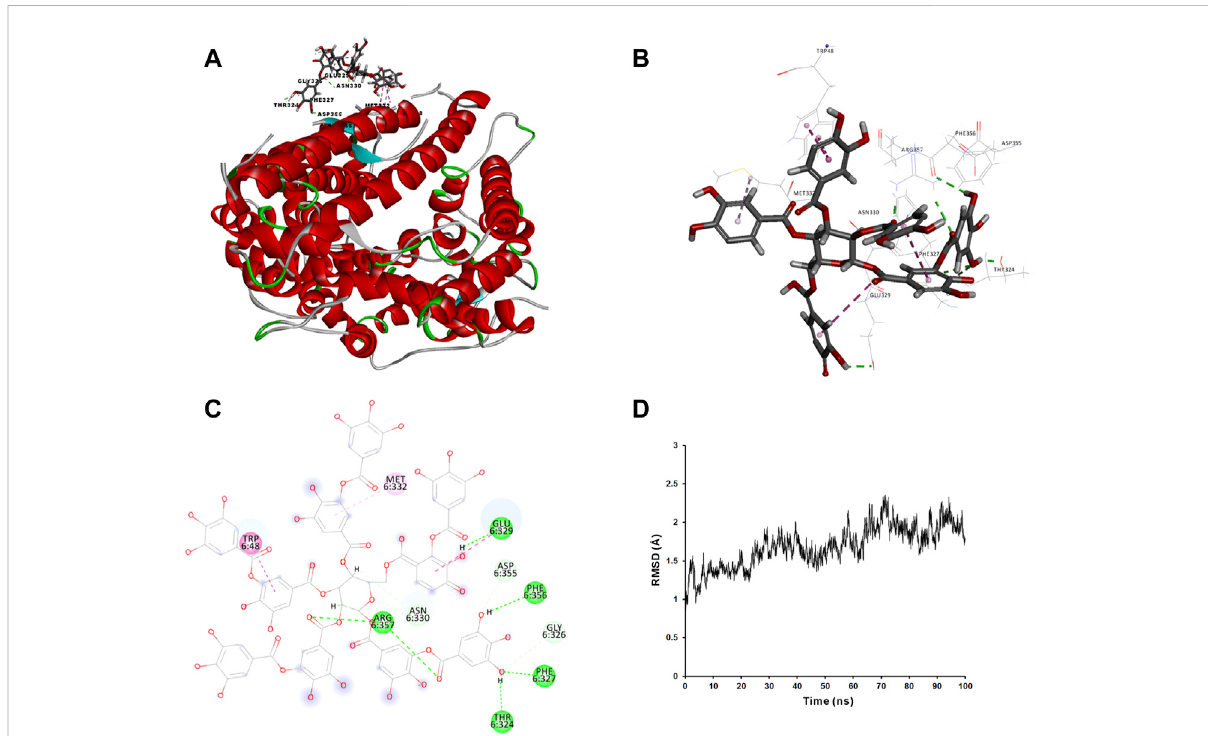
FIGURE 6 Molecular interaction of tannic acid with hACE2. Tannic acid and key residues were shown as sticks with carbon, oxygen and nitrogen colored gray, red and blue, respectively. Electrostatic interaction was shown as dashed lines with π - π , π -alkyl, and hydrogen bonds colored purple, pink, and green, respectively. (A) Binding feature of tannic acid with hACE2. Secondary structural elements are depicted as ribbons (coils, α -helices; arrows, β -sheets). Color is based on secondary structures ( α -helices, red; β -sheets, sky-blue; loops, green). (B) Molecular interaction of tannic acid with the residues of hACE2. The residues were shown in sticks and labeled in black. (C) Molecular interaction schemes oftannicacidwiththeresiduesofhACE2. (D)